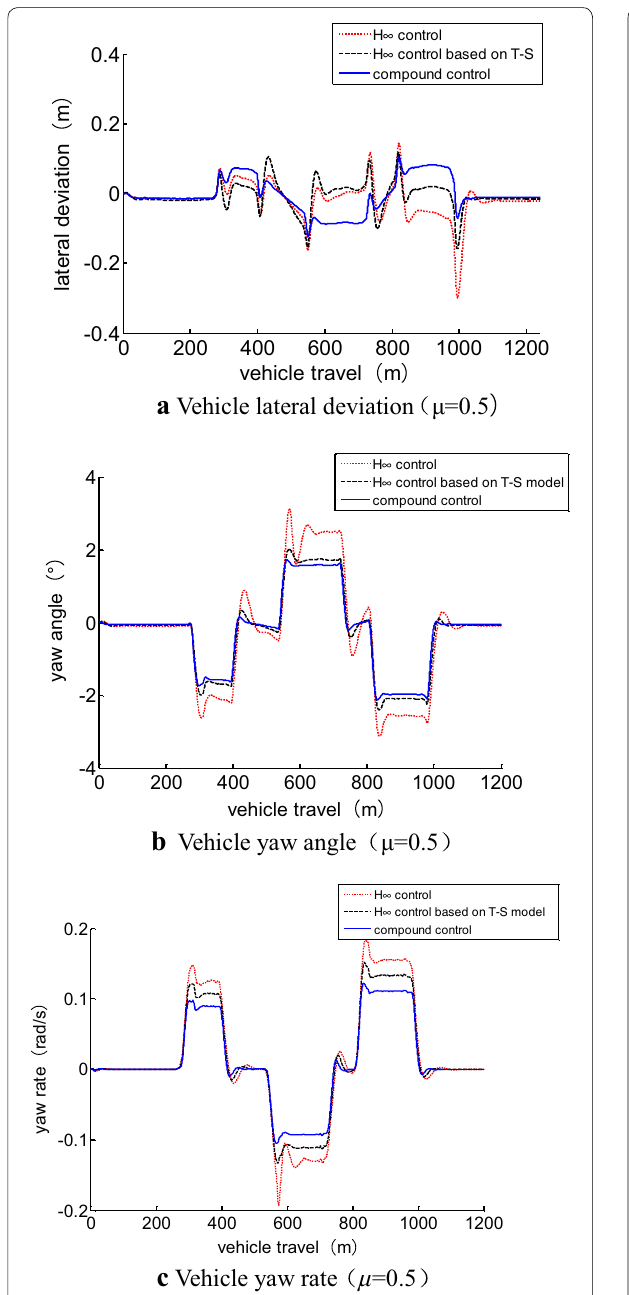
Figure 10 Vehicle driving situation on low road adhesion coefficient